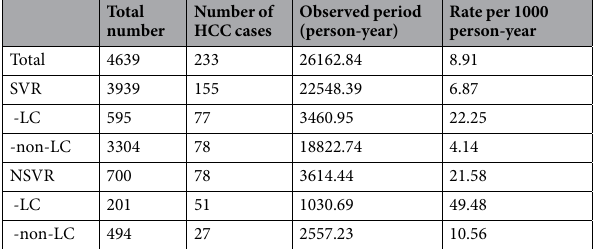
Table 2. Incidence of HCC, stratified by treatment response and presence of liver cirrhosis at study entry. HCC: hepatocellular carcinoma; SVR: sustained virological response; NSVR: non-sustained virological response;